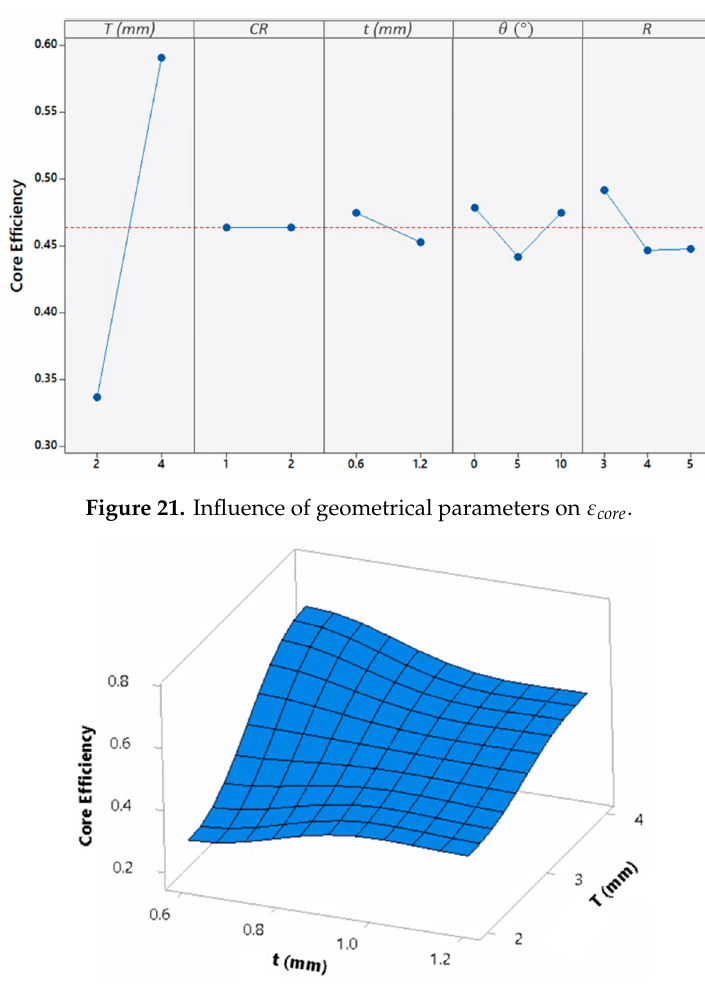
Figure 22. Dependence of (cid:2013) (cid:3030)(cid:3042)(cid:3045)(cid:3032) on the interaction of top-plate and tube thicknesses.